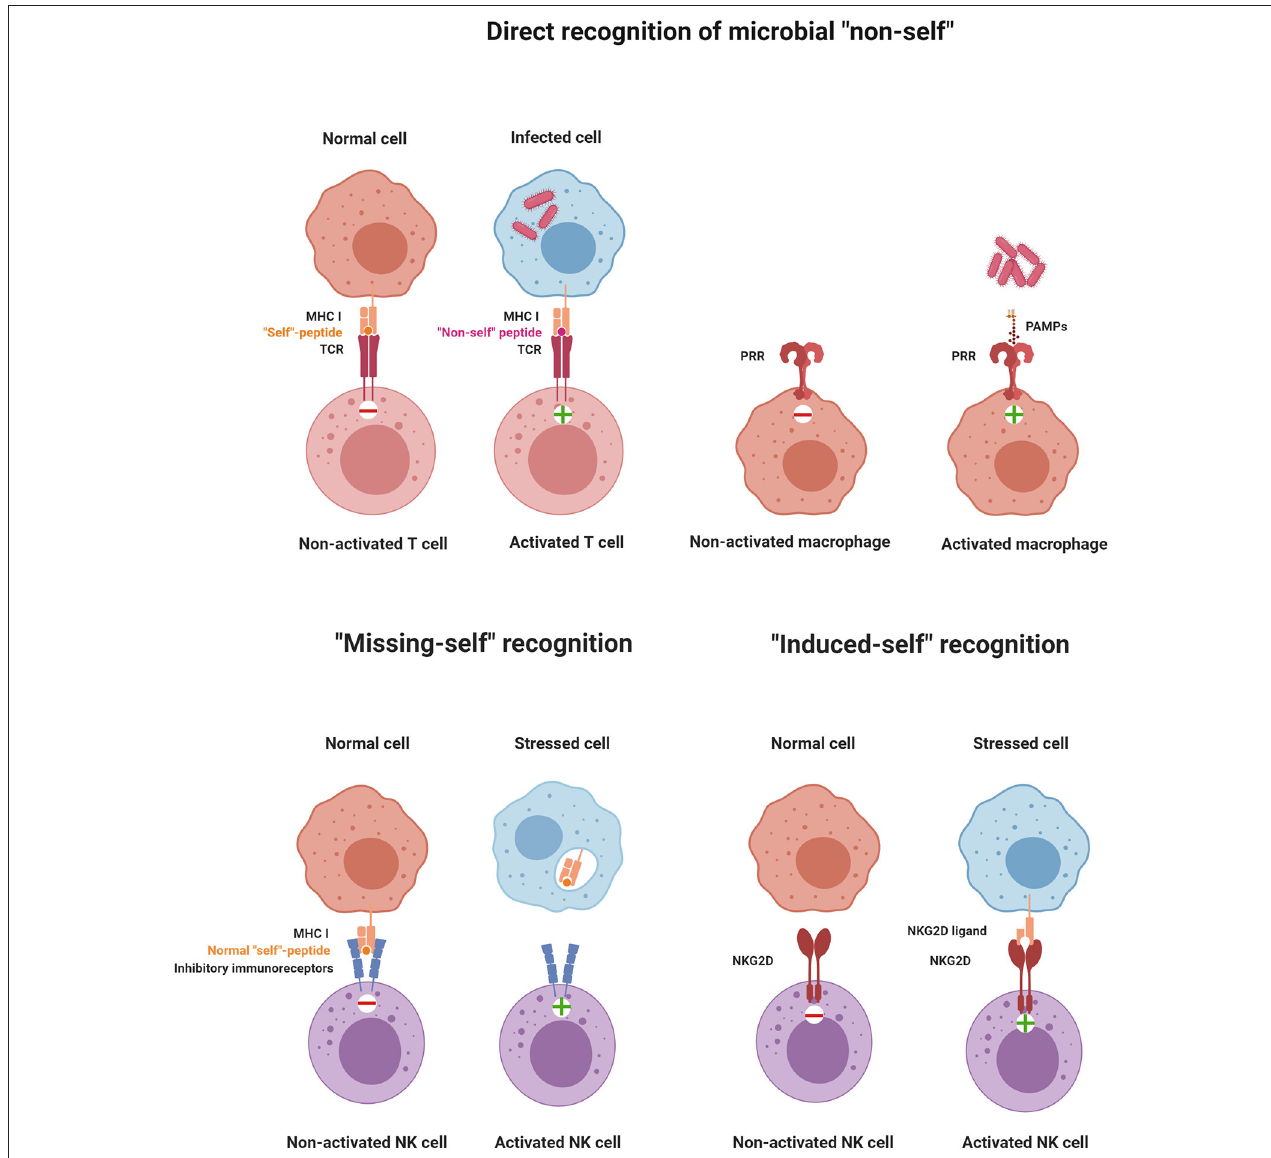
FIGURE 1 | Principles of immune recognition. The immune system constantly senses the presence or absence of “self” and “non-self” molecules by stimulatory and inhibitory receptors. Activation of immune cells is triggered by the direct recognition of microbial “non-self,” “missing-self” recognition, or “induced-self” recognition (illustrations were created with